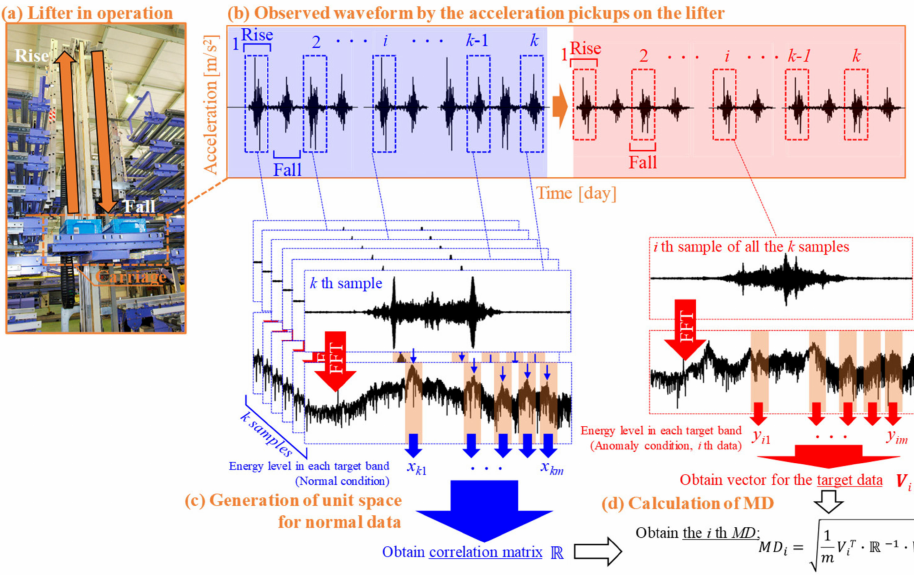
Figure 2. Simulation of Mahalanobis distance (MD) using the vibration acceleration data. The waveforms of the vibration as shown in ( b ) can be obtained by operating ( a ) the lifter. Then, by using ( c ) the generated unit space for normal data, finally ( d ) the MD can be